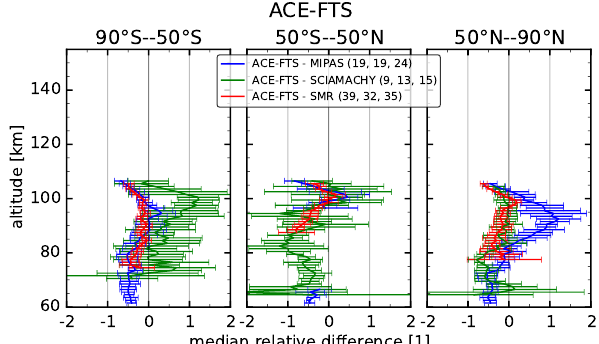
Figure 8. NO vertical profile comparison of the ACE-FTS data . NO n ACE-FTS . See Fig. 5 for NO